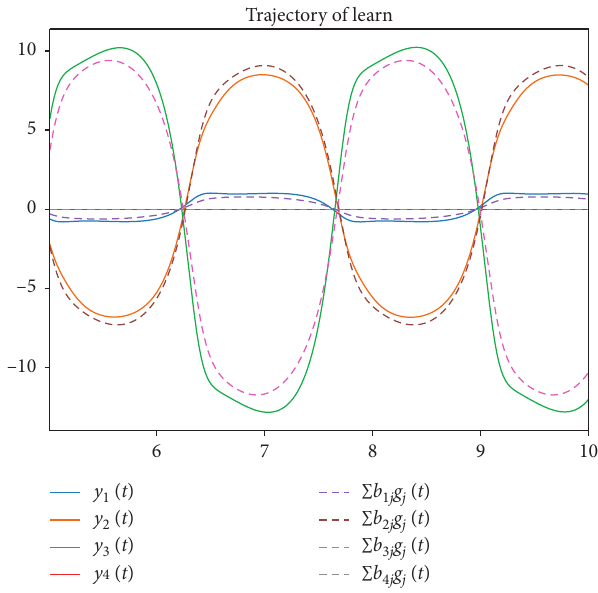
Figure 1: Learning result (this figure shows the learning result in (6) which is based on the optimization problem in (3). 􏽐 b ij g j ,i � 1 , 2 , 3 , 4 { } represents 􏽐 q j � calculation).